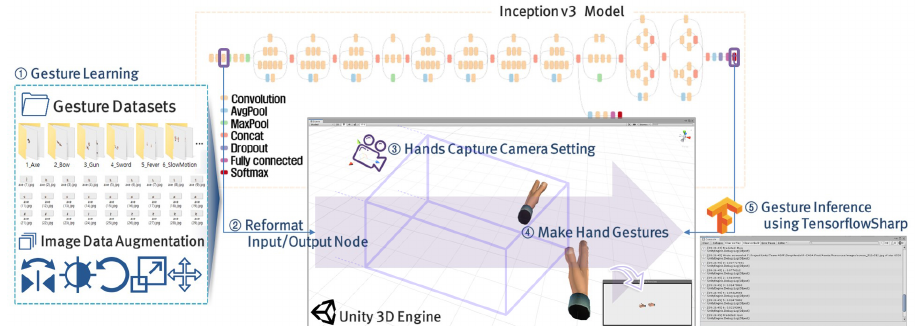
Figure 4. Deep learning model structure for gesture to action interface and process of inference in Unity 3D